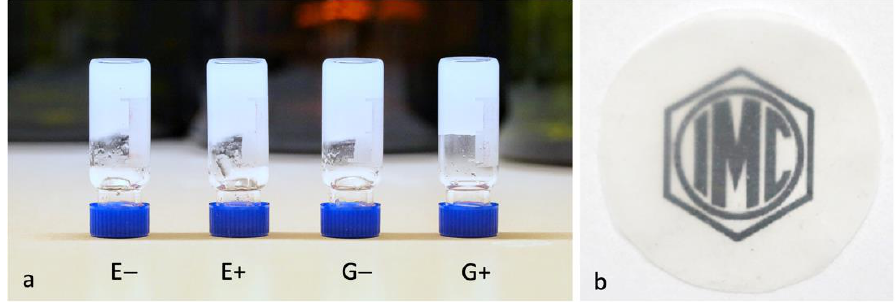
Figure 2. Photos of BC-NF dispersions prepared under different conditions ( a ) and example of dried BC-NF paper ( b ).